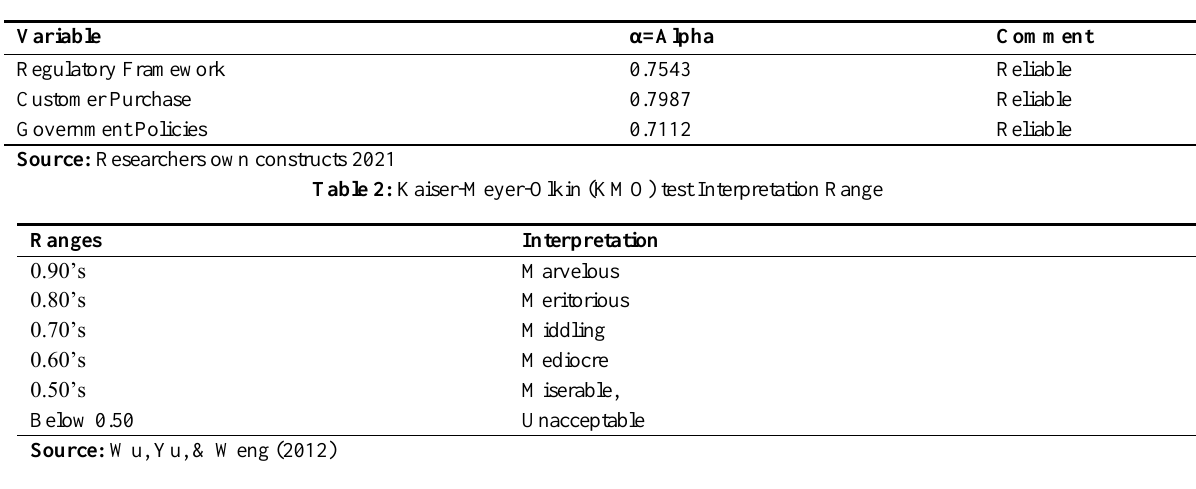
Table 1: Reliability Results